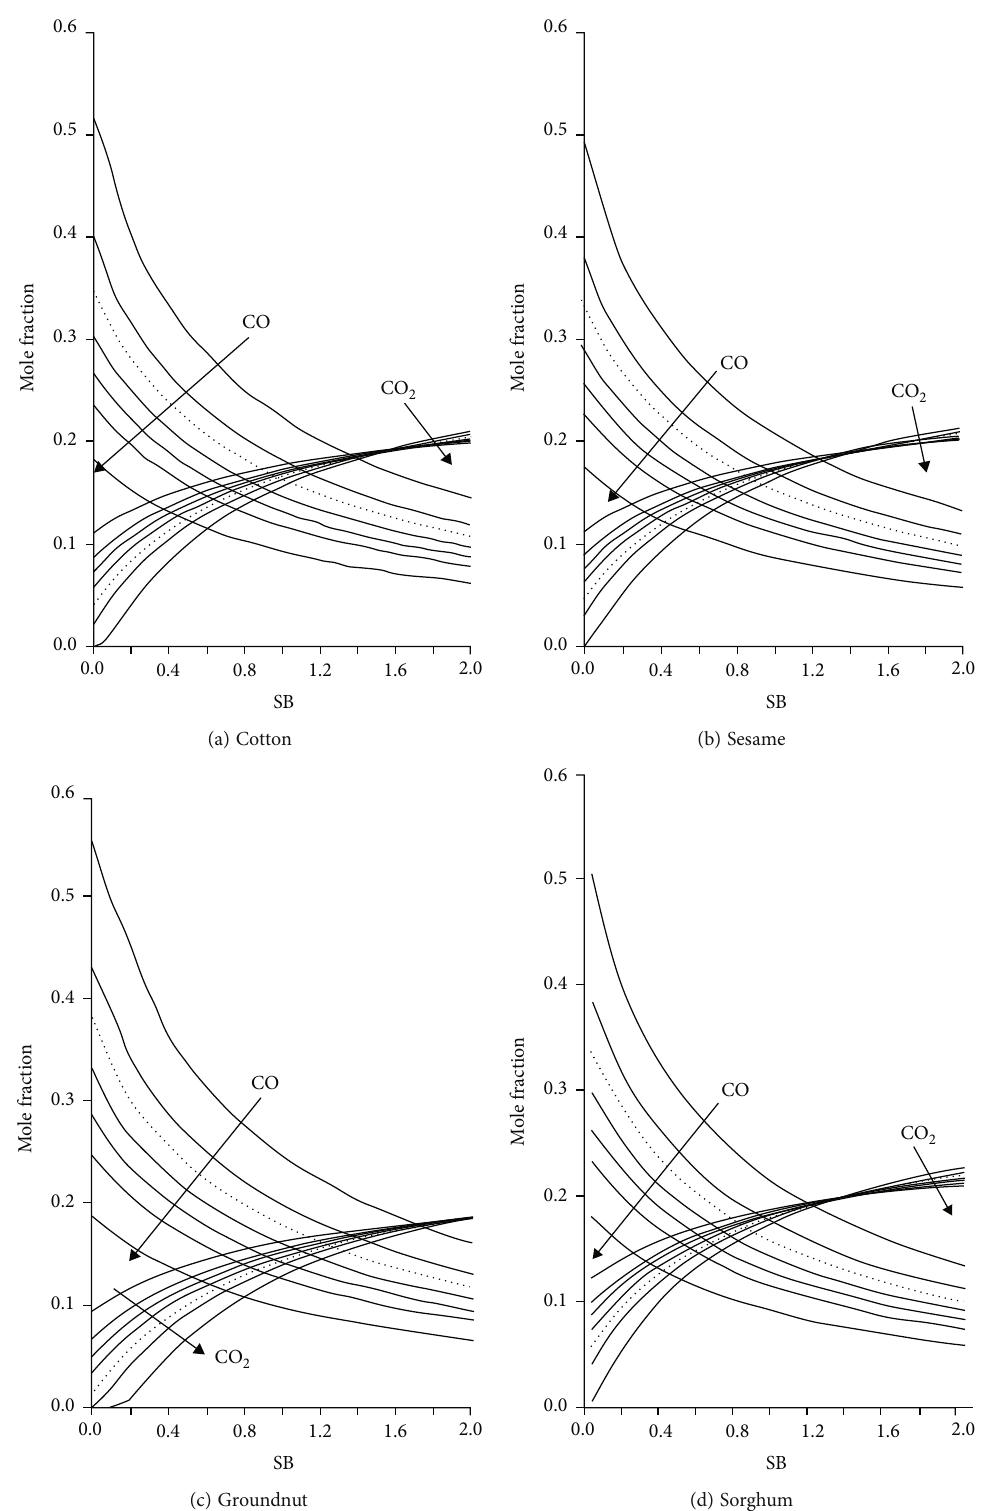
Figure 3: CO and CO concentration vs. ER and SB. Dotted curves at ER = 0 : 15 . The arrow indicates increasing 2